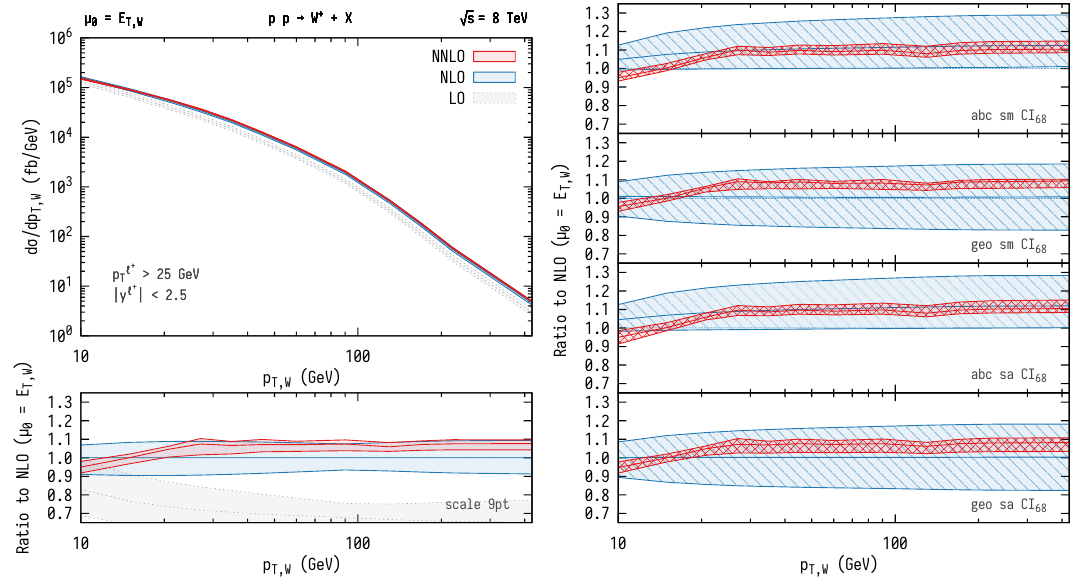
Figure 20 . W + +jet production up to NNLO with µ 0 = E T,W as the central scale choice. Left: absolute dσ/dp distributions and 9-point scale variation envelopes normalised to the NLO pre- T,W diction at µ . Right: 68% CIs for the abc and geometric models using the scale-marginalisation (top) 0 and scale-averaging (bottom) prescriptions (also normalised to